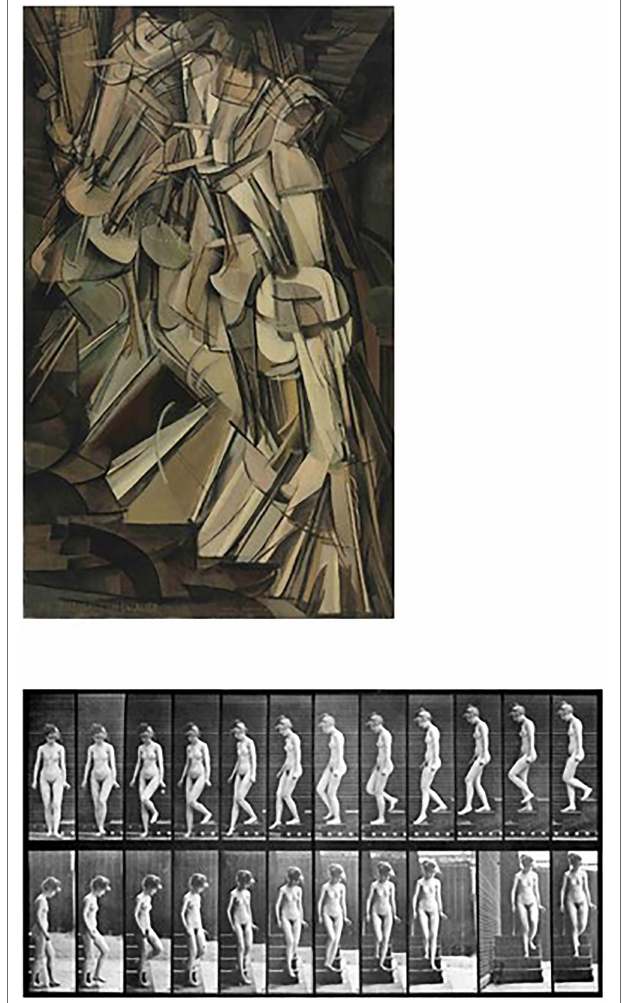
FIGURE 2 | Top: Nude descending a staircase No. 2 by Marcel Duchamp (1912). Bottom: Woman walking downstairs by Muybridge (1887). Reproduced with